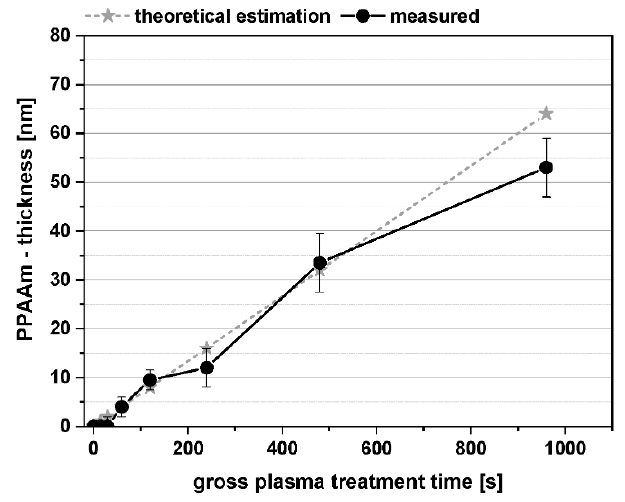
Figure 5. PPAAm film thickness dependent on the plasma treatment time determined on Si-wafers.